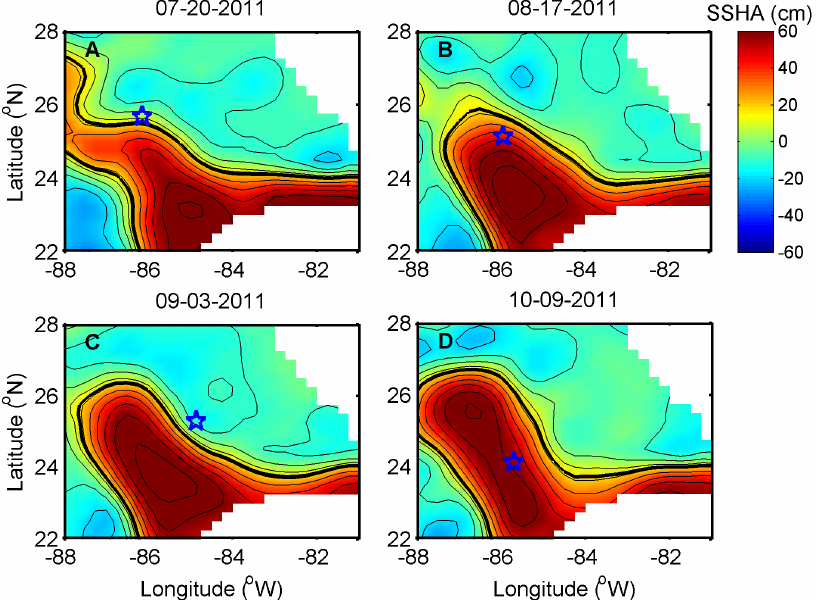
Figure 2. Example comparisons of SSHA fields to float surfacing locations on four dates. (A) July 20 th , (B) August 17 th , (C) September 3 rd , and (D) October 9 th , 2011. The float location (blue star) is identified relative to the Loop Current boundary, as determined by the 17-cm isopleth (thick black line).